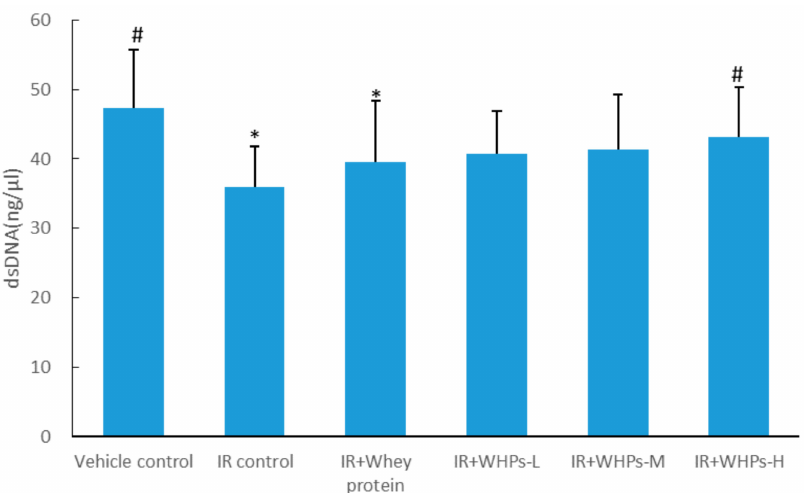
Figure 4. Effect of WHPs on DNA content in bone marrow at day three after radiation. * The difference was statistically significant ( p < 0.05) compared with the vehicle control group; # the difference was statistically significant ( p < 0.05) compared with the IR control group. IR, irradiated mice; IR+WHPs-L, irradiated mice+low-dose whey hydrolysate peptides; IR+WHPs-M, irradiated mice+medium-dose whey hydrolysate peptides; IR+WHPs-H, irradiated mice+high-dose whey hydrolysate peptides.